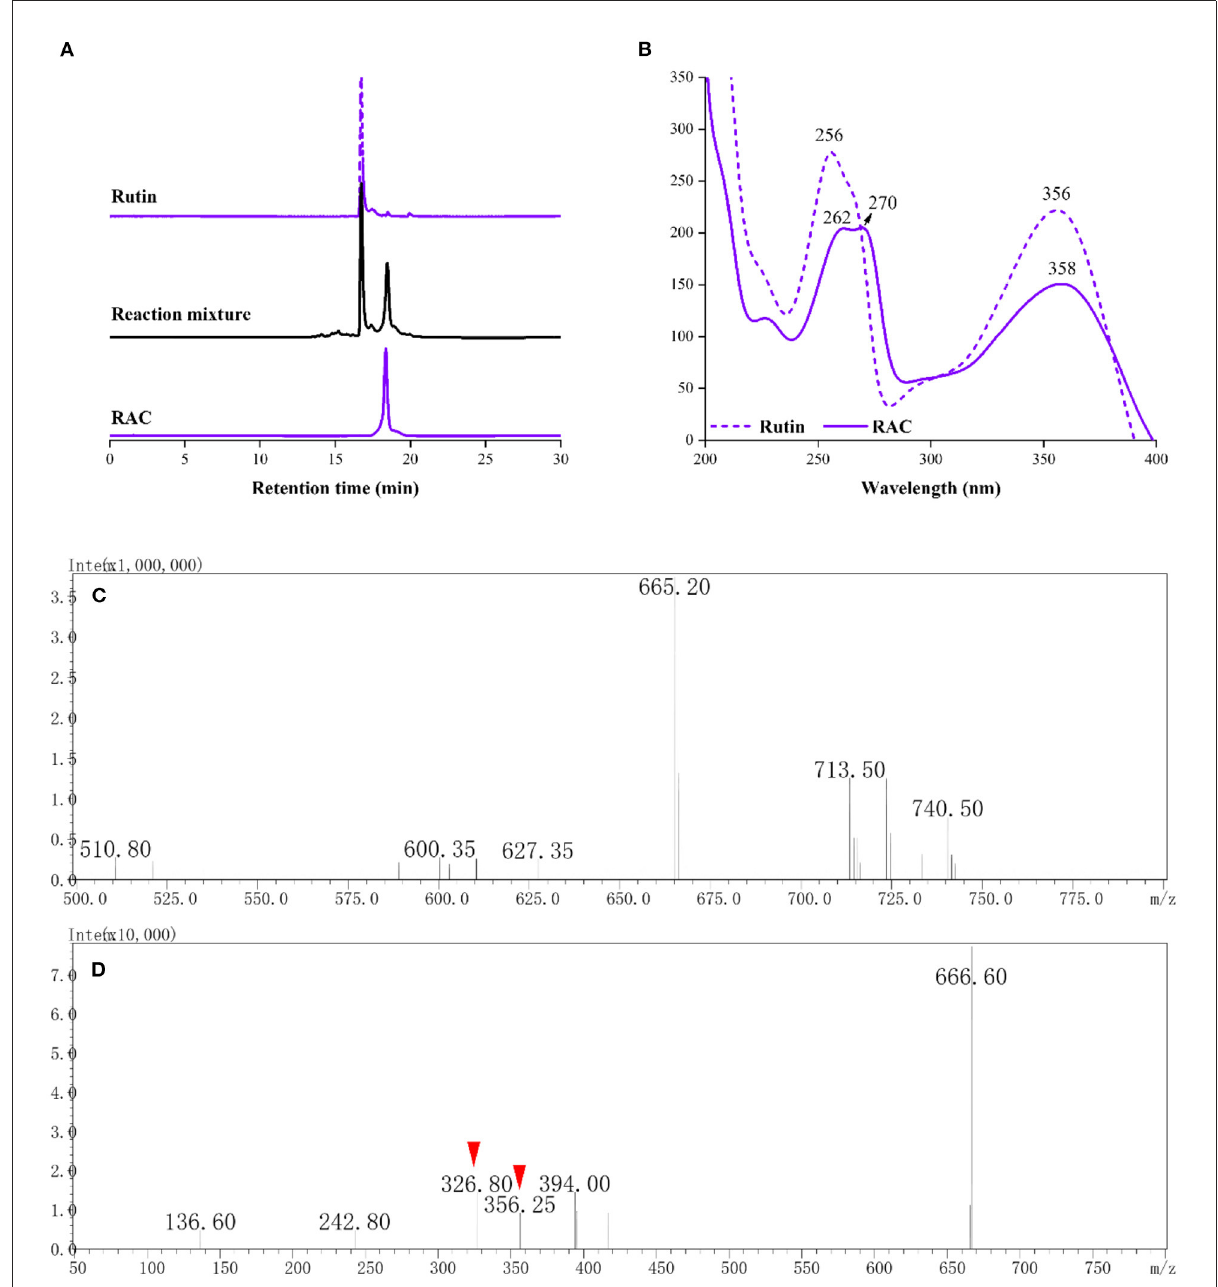
FIGURE2 The (A) HPLC chromatograms and corresponding (B) UV spectra of rutin, reaction mixture and RAC, and the (C) MS and (D) MS/MS spectra of RAC.